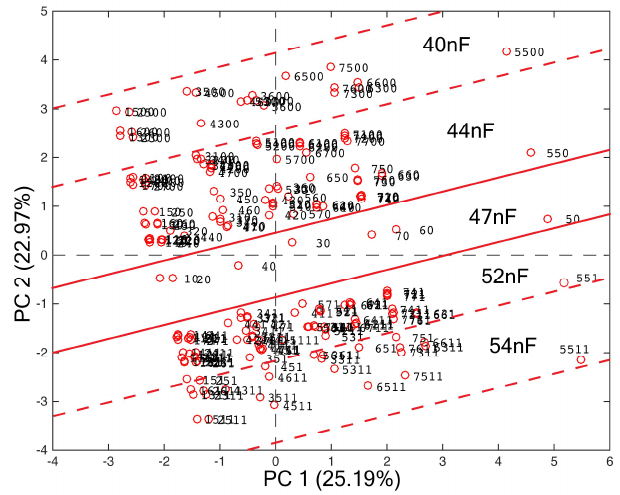
Figure 11. Score plot of the first two PCs of the principal component analysis (PCA) model built in the 7 13 data array of resonance frequency of the seven-cell L–C L.N. of Figure 5. ×